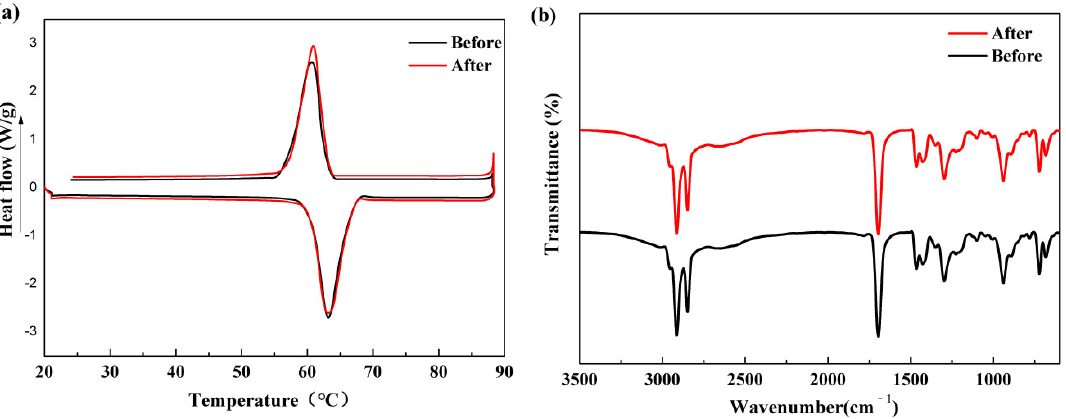
Figure 11. The DSC curves ( a ) and FT-IR spectrum ( b ) of PA/HGA3 before and after 100 thermal cycles.